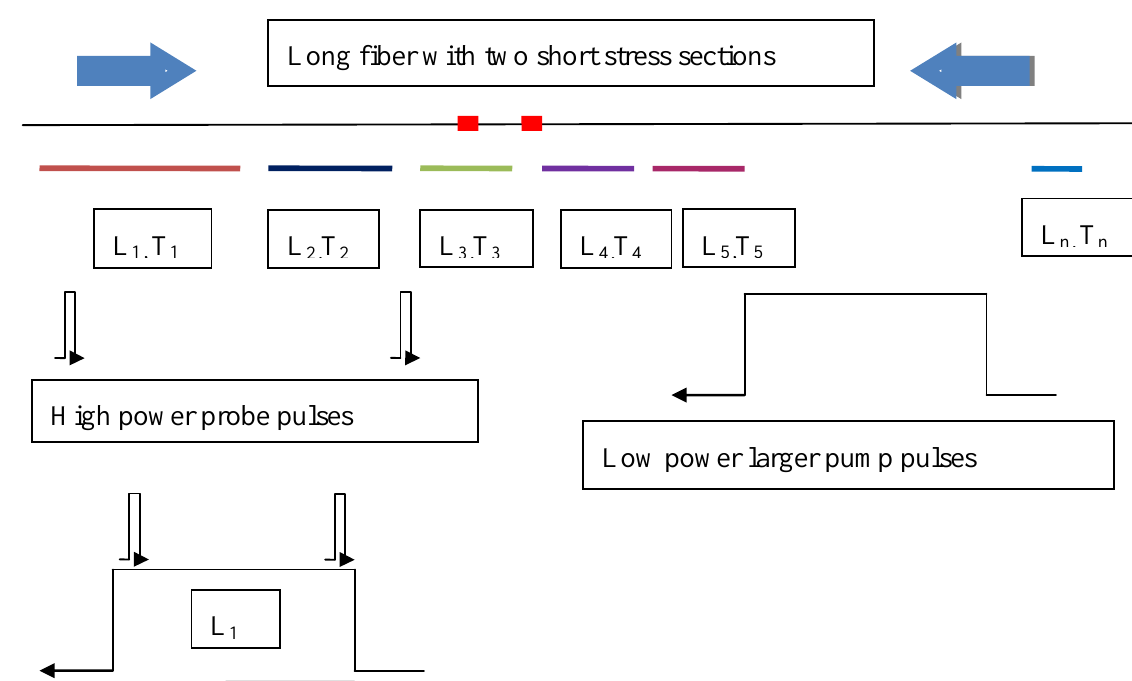
Figure 7. Time-division-multiplexing for 100 km sensing